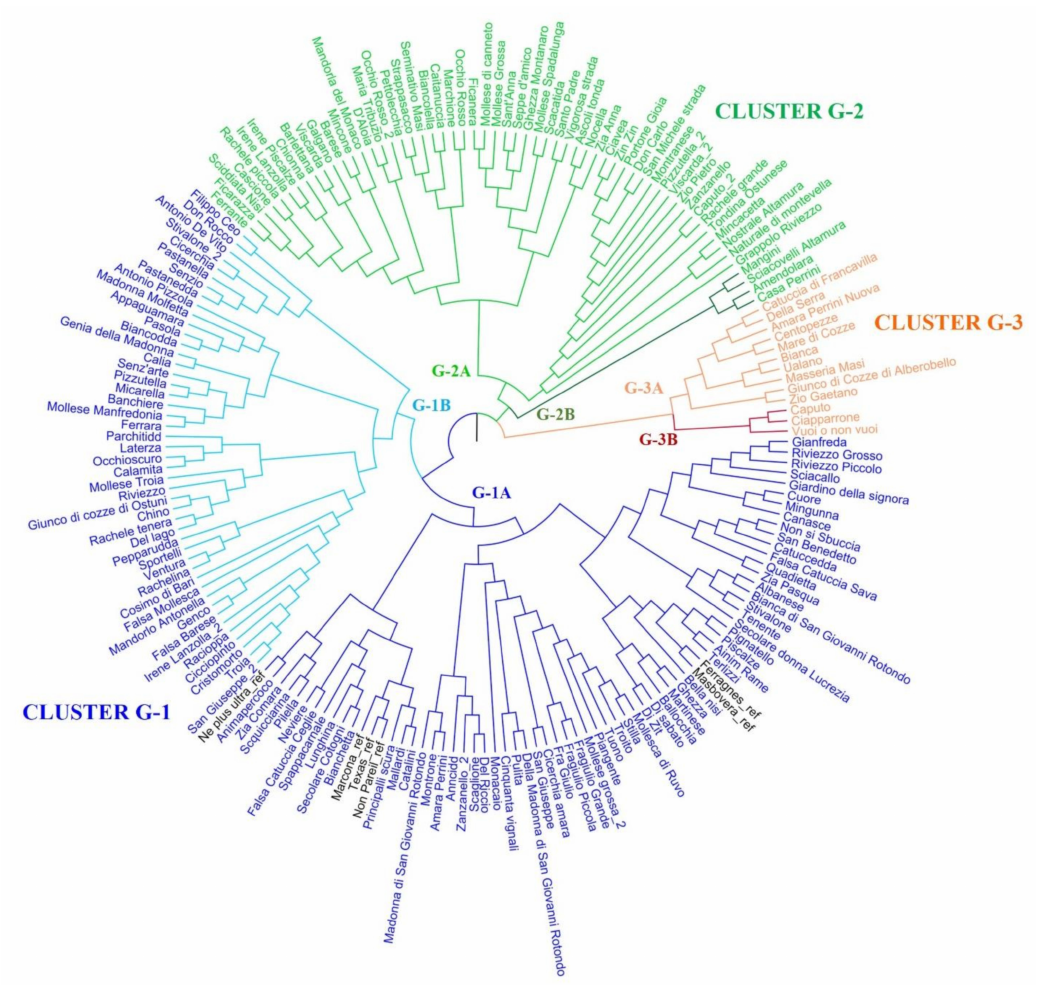
Figure 1. Dendrogram of the Apulian almond population based on genetic distance. Genotypes names are colored according to the main clusters they belong to (blue for G-1, green for G-2, and orange for G-3). Reference cultivars are colored black.